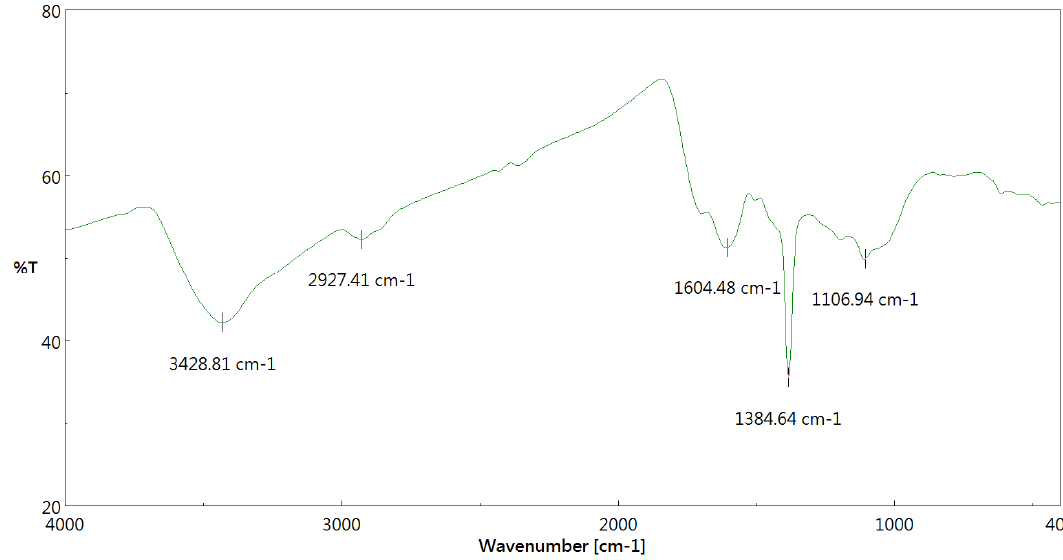
Figure 6. FTIR spectrum of the optimal torrefied RH product (T-RH-280-30).